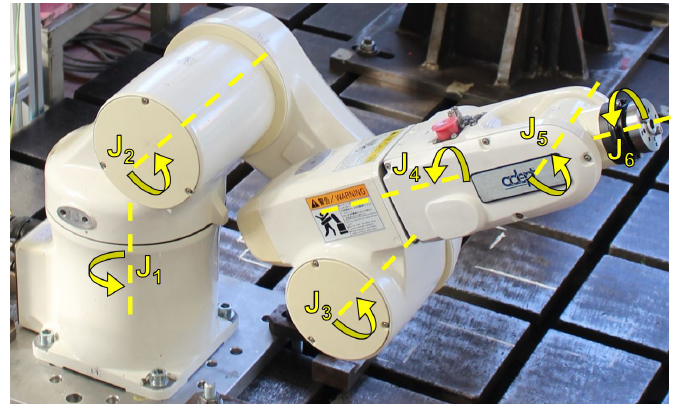
Figure 9. Robot: Adept Viper